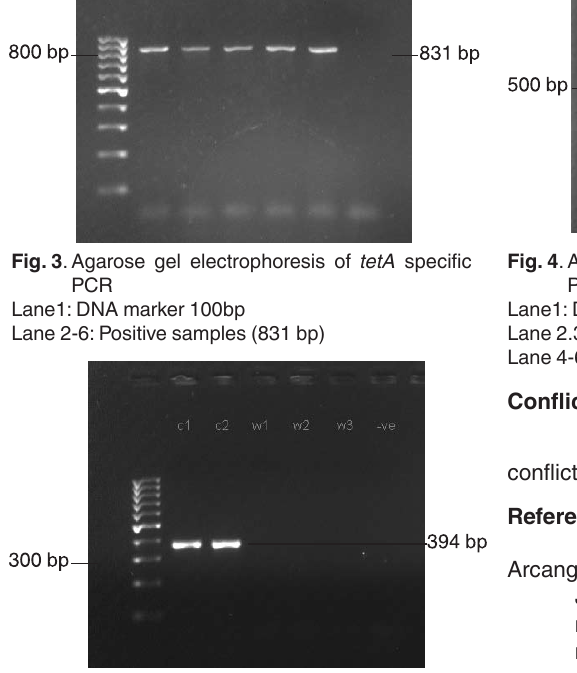
Fig. 5. Agarose gel electrophoresis of clmA specific PCR Lane1: DNA marker 100bp Lane 2.3: Positive samples (394 bp) Lane 4-6: Negative